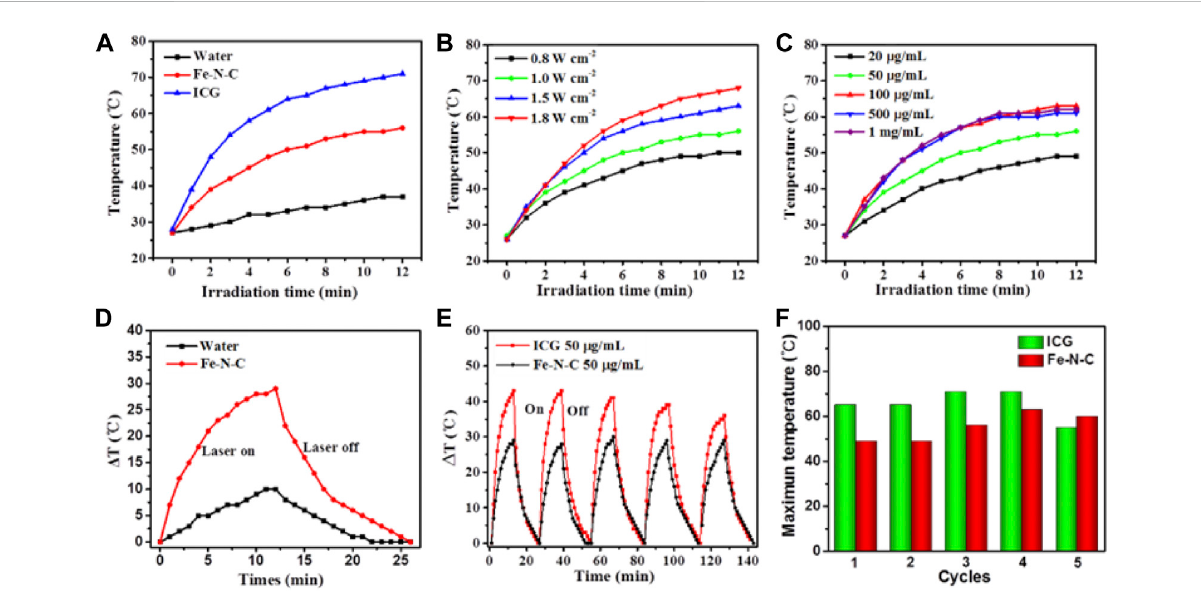
FIGURE 3 Photothermalconversionperformance. (A) Fe-N-CSAzymes,ICGaqueoussolutionsandpurewaterunderirradiationwithan808 nmlaserata power density of 1.0 W cm − 2 for 12 min. (B) Fe-N-C SAzymes dispersion solutions with the constant concentration of 50 μ g/ml under 808 nm laser irradiation at different power density of 0.8, 1.0, 1.5, 1.8 Wcm − 2 for 12 min. (C) Fe-N-C SAzymes dispersion solutions with different concentrations (20,50,100,500and,1,000 μ g/ml)under808 nmlaserirradiationatapowerdensityof1.0 Wcm − 2 for12 min. (D) Heatingandcoolingcurvesof Fe-N-C SAzymes aqueous solution and pure water irradiated with an 808 nm NIR laser (1.0 W cm − 2 ). (E) Stability of Fe-N-C SAzymes and ICG aqueous solutions under irradiation with an 808 nm laser at a power density of 1.0 W cm − 2 for fi ve on/off cycles. (F) The maximum temperature changes during fi ve cycles between Fe-N-C SAzymes and ICG aqueous solutions after 808 nm laser irradiation. Data are representative of three independent